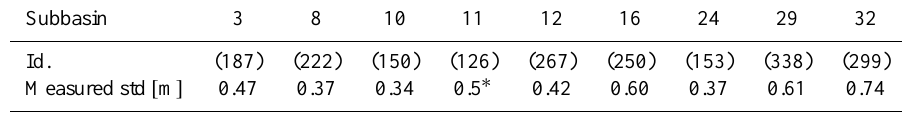
Table 1. Measurement uncertainty, numbers in parenthesis refer to the VS numbers in Michailovsky et al.